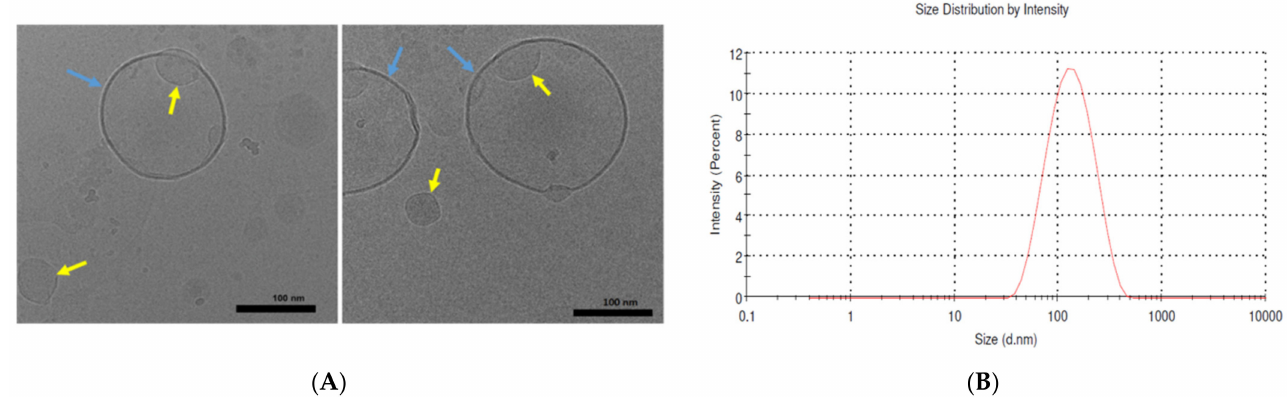
Figure 3. ( A ) Cryogenic electron microscopy (Cryo-EM) images of the BBR-loaded liposomes fabricated by the ethanol- injection method (FJ21). The micrographs show the unilamellar vesicle (UV) structure of the liposomes. Scale bar = 100 nm. ( B ) The size distribution of the corresponding liposomes (FJ21) determined by the Zetasizer Nano ZSP